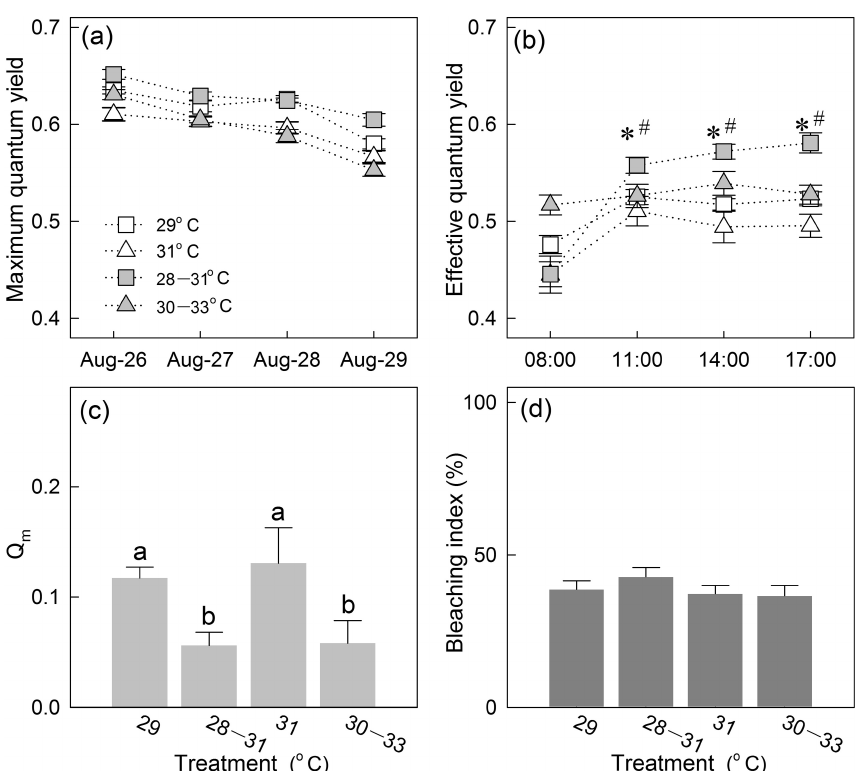
Figure 3. Photo-physiology and bleaching of P. damicornis recruits under constant and fluctuating conditions of two temperatures (29 and 31 ◦ C): (a) F v /F m over 4 consecutive days; (b) (cid:49)F/F (cid:48) m throughout the last day of the experiment; (c) Q m and (d) bleaching rates. Error bars represent 1SEM ( n = 20 for F v /F m ; n = 15 for (cid:49)F/F (cid:48) m and Q m ; n = 25–33 for bleaching index). Asterisks and hashes indicate significant effects of temperature increase and fluctuations at a specific time, respectively. Different letters represent significant differences between